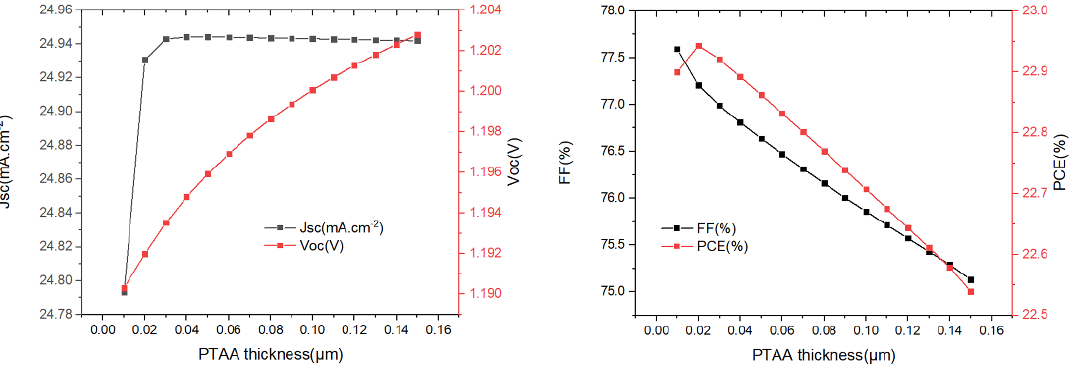
Figure 7. The variation of J sc , V oc , FF , and PCE with different PTAA-HTL layer (0.01 µ m to 0.15 µ m) thicknesses.